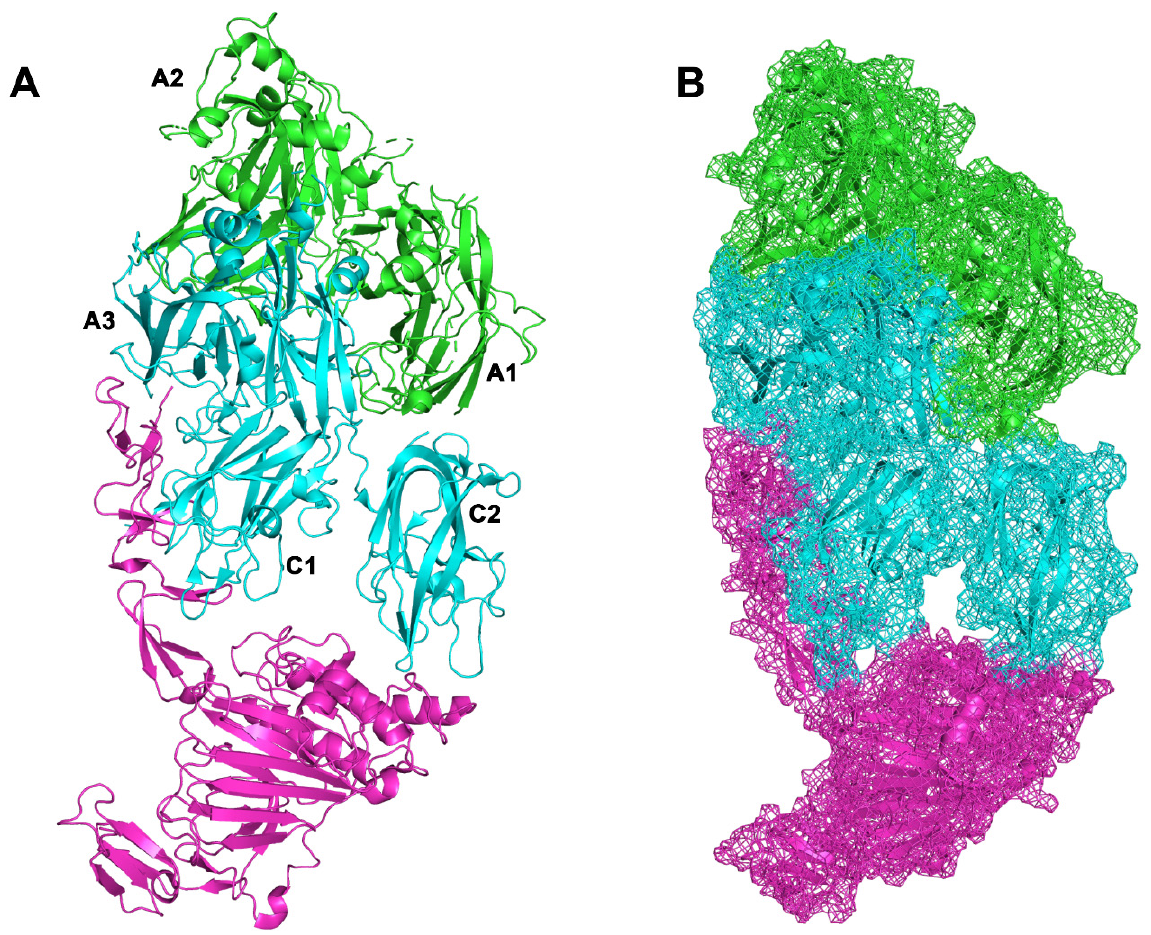
Figure 4. Efanesoctocog alfa ( A ) FVIII is represented in green cartoon (heavy chain) and cyan cartoon (light chain). VWF is represented with magenta cartoon. ( B ) Surfaces representation as mesh. Capital letters refer to protein domains of FVIII.